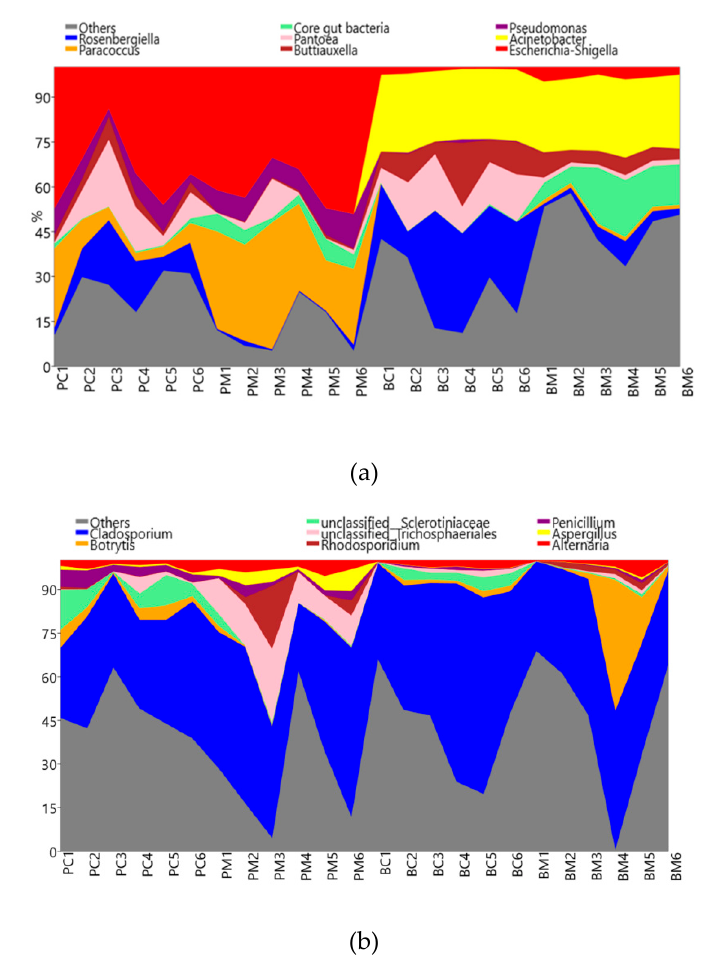
Figure 2. Stack area graph, showing the dynamics in the structure of bacterial ( a ) and fungal ( b ) communities in corbicular pollen and hive-stored bee bread in two honey bee species.